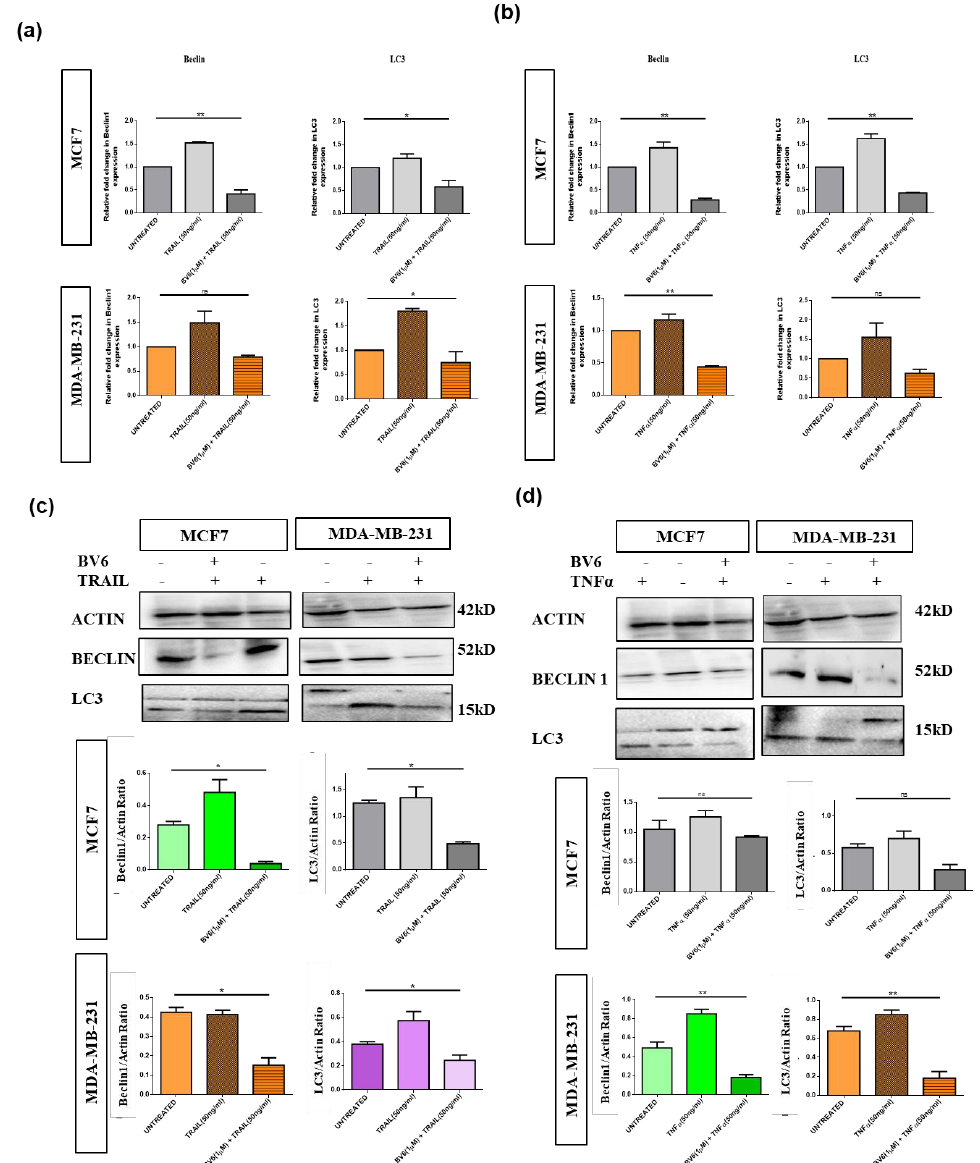
Figure 7. Expression analysis of autophagy biomarkers (Beclin1 and LC3) in MCF7 and MDA-MB-231 cells treated with TRAIL (50 ng/mL), TNF α (50 ng/mL) and their combination with BV6 (1 µ M) with the help of real-time PCR and western blotting: ( a ) The relative fold change in Beclin-1 and LC3 mRNA expression levels normalized by Actin in both breast cancer cell lines treated with TRAIL (50 ng/mL) alone and in synergy with BV6 (1 µ M). ( b ) The relative fold change in the Beclin-1 and LC3 mRNA expression levels normalized by Actin in both breast cancer cell lines treated with TNF α (50 ng/mL) alone and in synergy with BV6 (1 µ M). ( c ) Western Blot images showing the protein bands of untreated control and treated breast cancer cells with TRAIL (50 ng/mL) alone and in synergy with BV6 (1 µ M). Histogram displaying the Beclin-1 and LC3 protein expression levels normalized by Actin. ( d ) Western Blot images showing the protein bands of untreated control and treated breast cancer cells with TNF α (50 ng/mL) alone and in synergy with BV6 (1 µ M). Histogram displaying the Beclin-1 and LC3 protein expression levels normalized by Actin The experiments are carried out in triplicates displayed as mean ± SEM, and the data represented is statistically significant: (*) and (**) show p ˂ 0.05 and p ˂ 0.01, respectively.